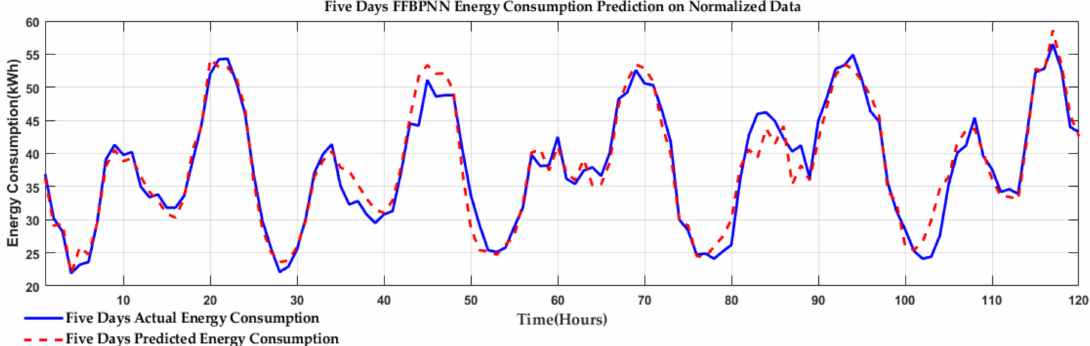
Figure 15. Five days of hourly energy consumption prediction using FFBPNN on normalized data.